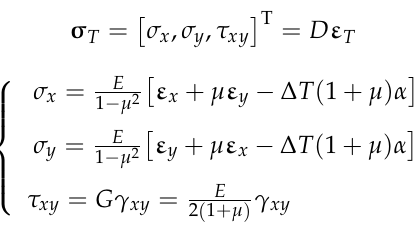
Here, µu and v are in-plane displacement, and w is the deflection of the thin plate at the equilibrium position. The ε 0 represents the midplane strain vector, and κ is the mid- plane curvature vector. Based on the Kirchhoff hypothesis of classical plate and shell the- ory and Karman type geometric nonlinearity [26], the total strain is obtained in Equation (3).